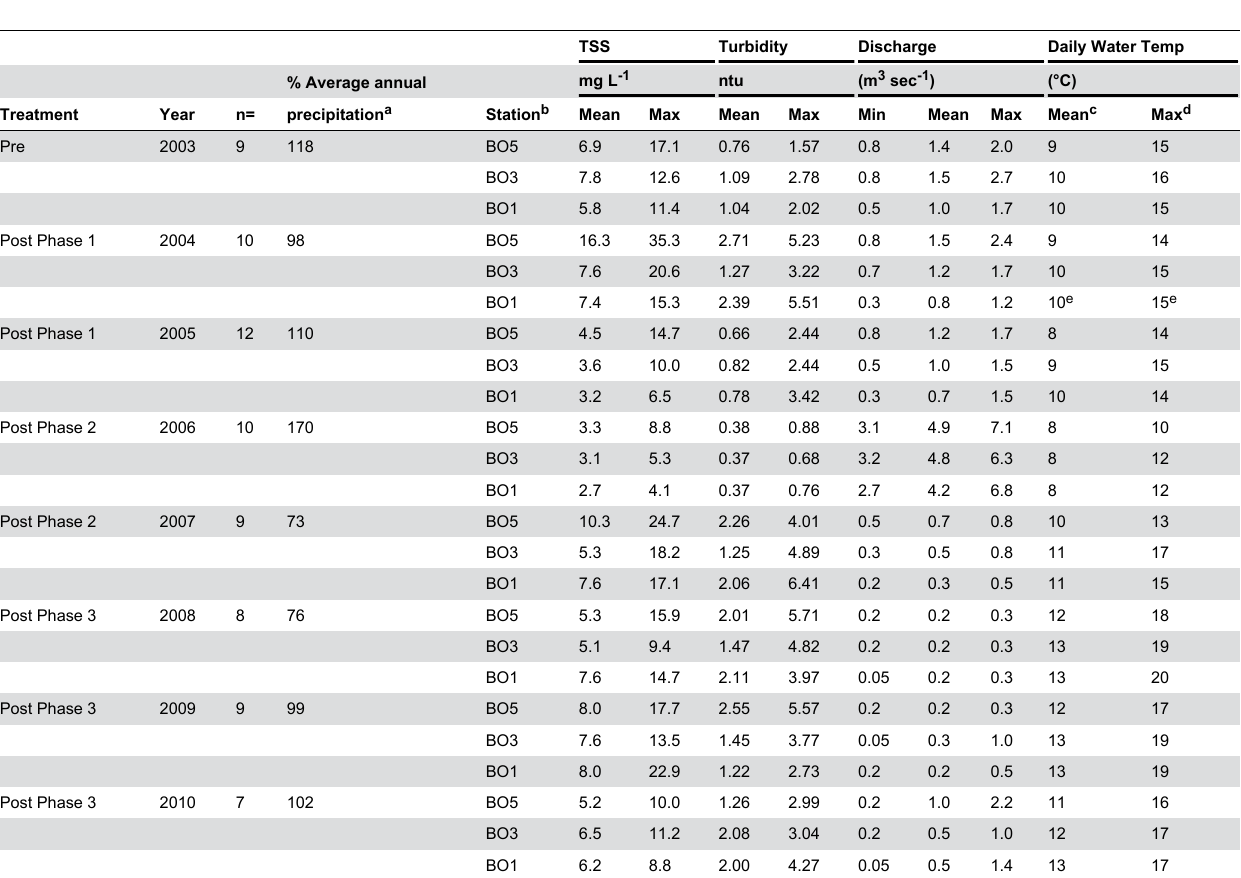
Table 4. Mean and maximum annual values of total suspended solids (TSS), turbidity, discharge and stream temperature measured at Bogard